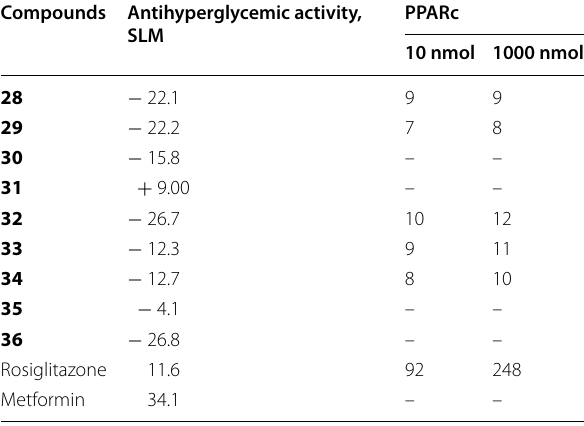
PPAR c proxisome proliferator activated receptor